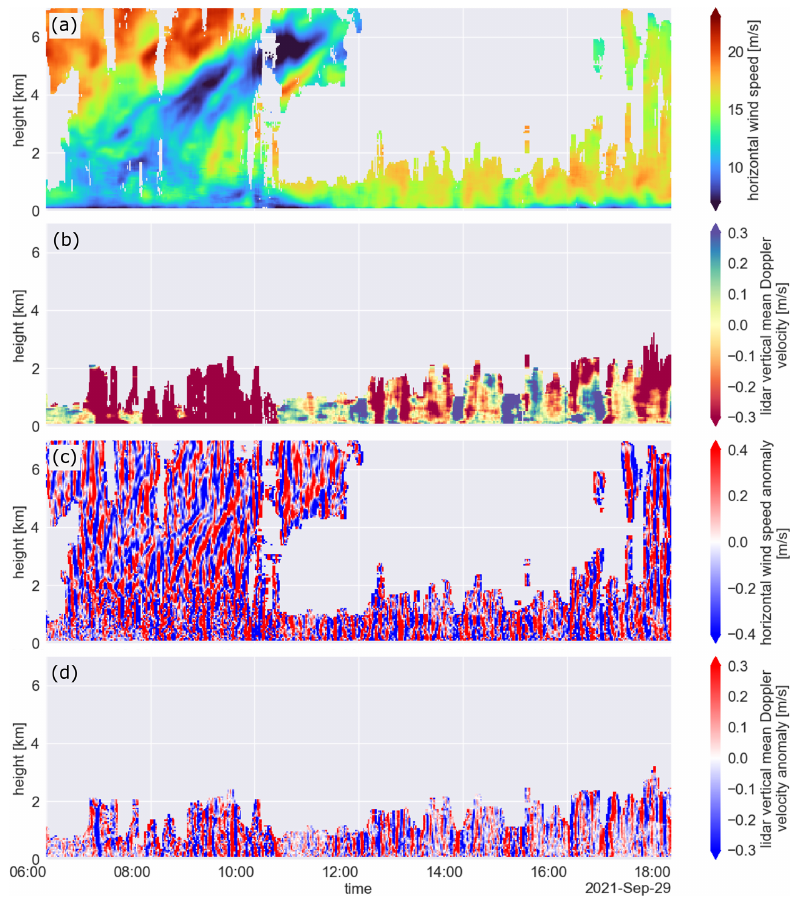
Figure 17. Time–height plots from 29 September 2021: (a) CMTRACE level 2 horizontal wind speed main component (10min averaged), (b) CMTRACE level 2 lidar vertical mean Doppler velocity (10min averaged, negative means towards the surface), (c) CMTRACE level 2 horizontal wind speed anomaly, and (d) CMTRACE level 2 lidar vertical mean Doppler velocity anomaly.